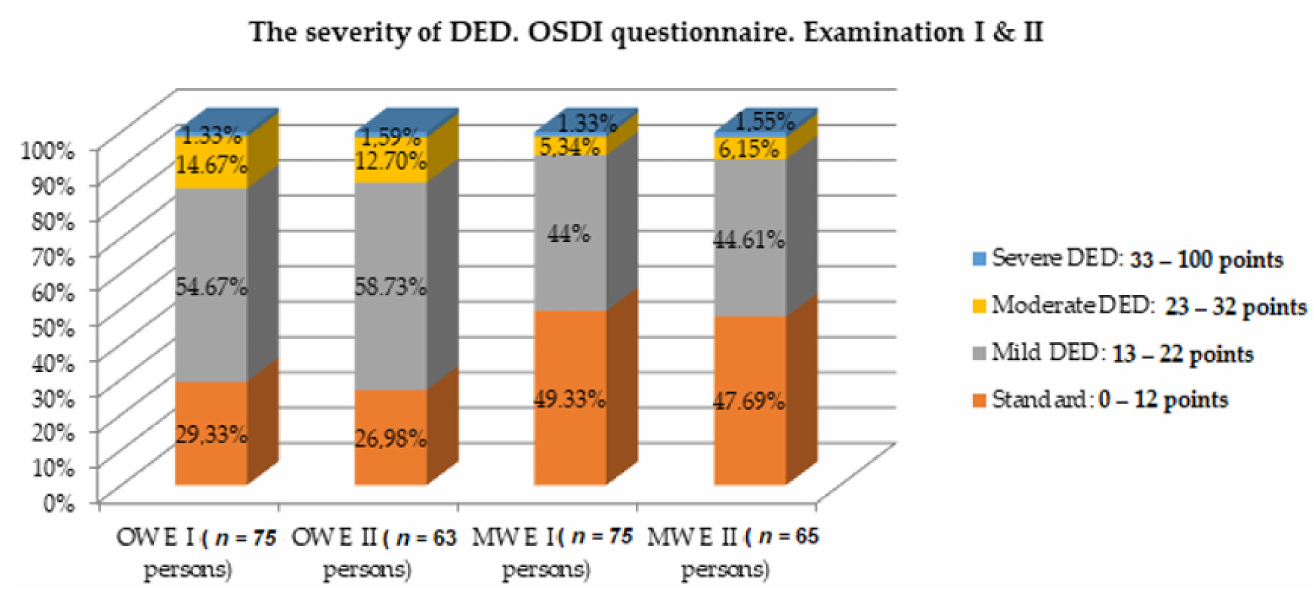
The Severity of DED OSDI Questionnaire